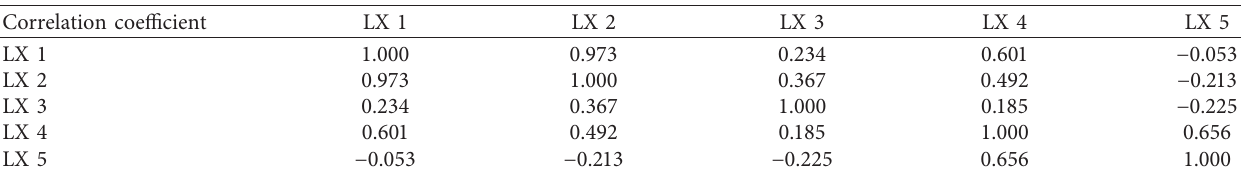
Table 2: Correlation coefficient.